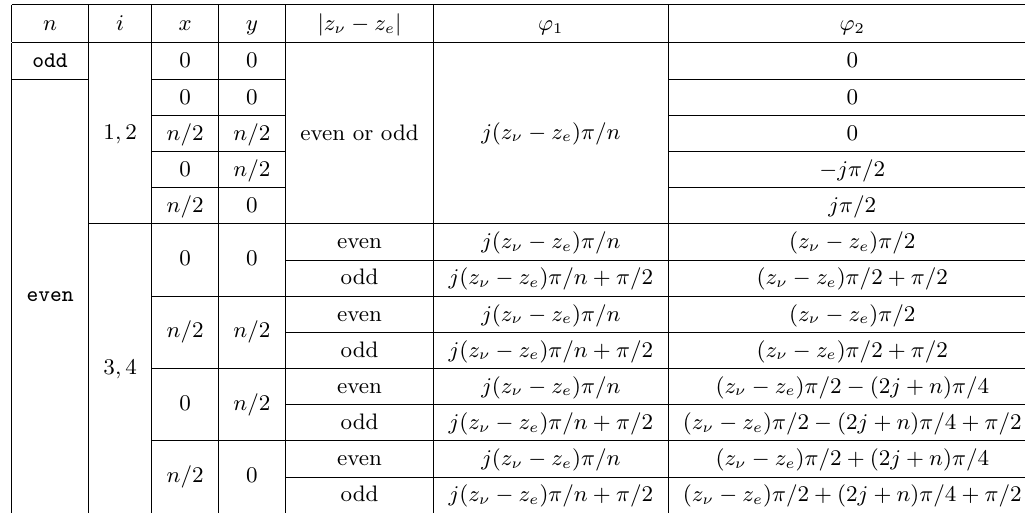
Table 1 . The values of the parameters ’ 1 and ’ 2 for the residual symmetries Z g e X e = f R (cid:0) z e + x ; SR x g , Z g (cid:23)